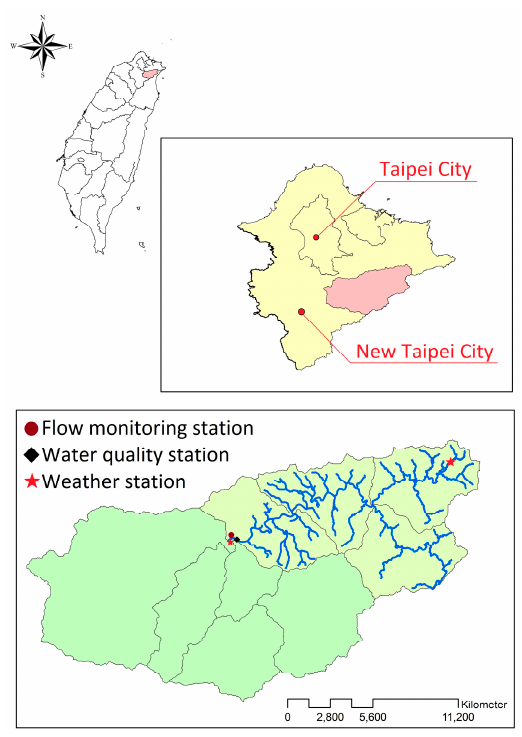
Figure 1. Location of the Peishi watershed.